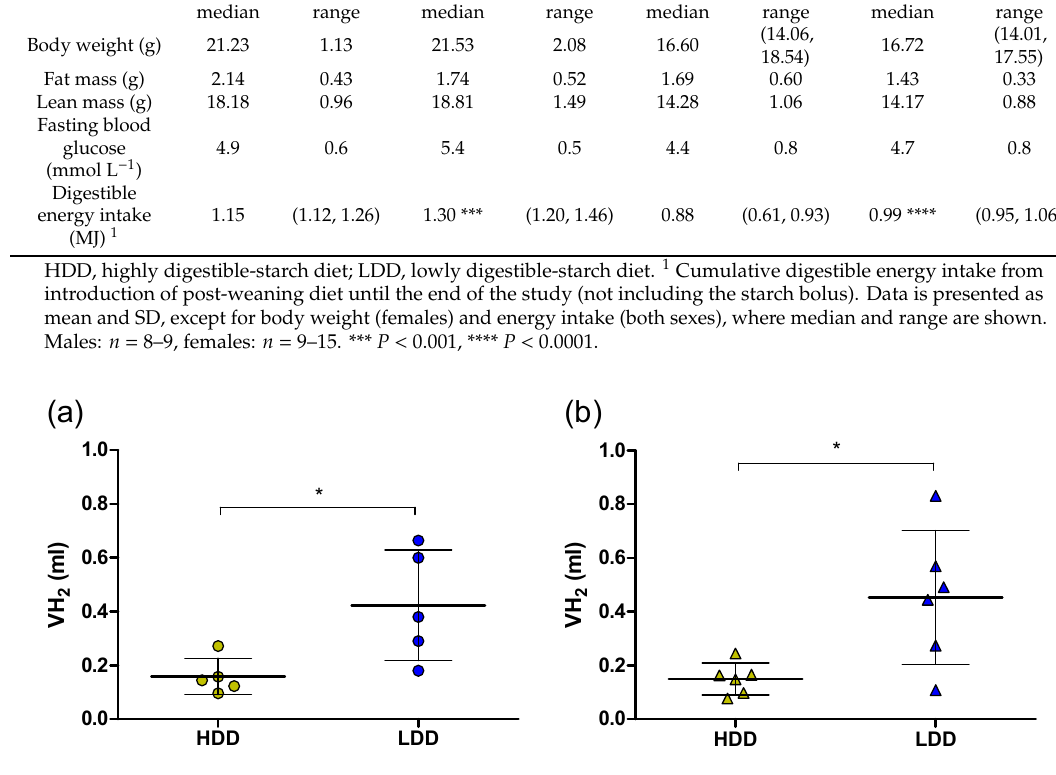
Figure 1. Cumulative 24 h H 2 production on highly digestible-starch diet (HDD) or lowly digestible-starch diet (LDD). ( a ) Males ( n = 5; PW 4), ( b ) females ( n = 6; PW 3). Data are presented as mean and SD. Student’s t -test, * P < 0.05. HDD, highly digestible-starch diet; LDD, lowly digestible-starch diet; PW, post-weaning week.